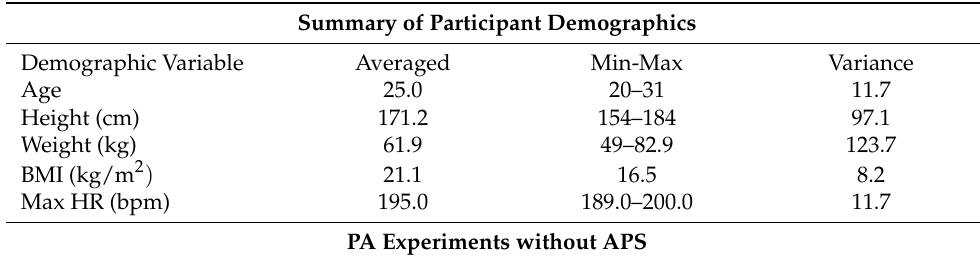
Table 2. The participants’ general demographic information and information on experiments con- ducted for data collection during sedentary state, treadmill running, and stationary